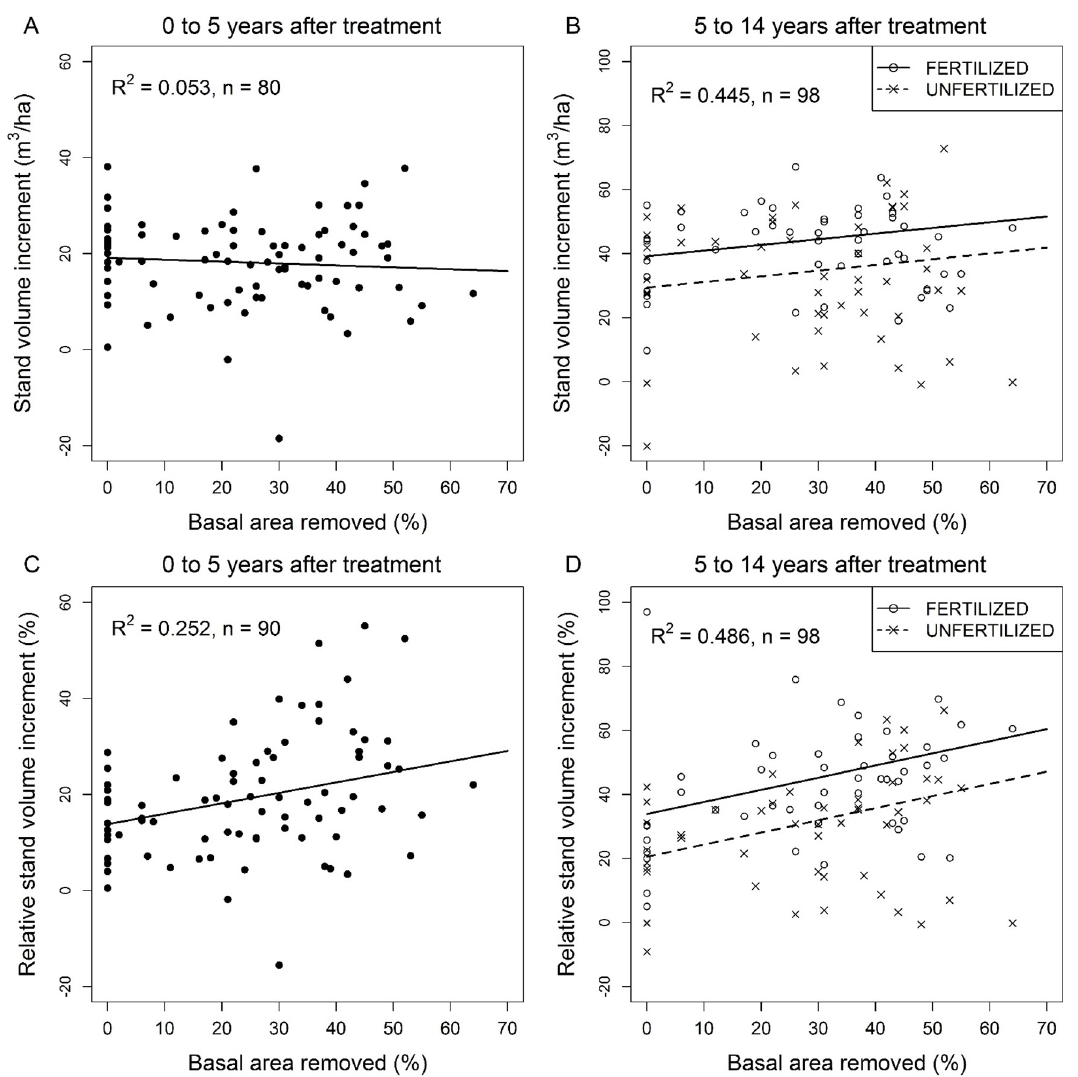
Figure 5. Jack pine stand response to commercial thinning and fertilization over the 5- to 14-year period following commercial thinning; ( A ) Stand volume increment over the first 5 years after commercial thinning in unfertilized plots as a function of basal area removed; ( B ) Stand volume increment between 5 and 14 years after thinning as a function of basal area removed and fertilization; ( C ) Relative stand volume increment over the first 5 years after commercial thinning in unfertilized plots as a function of basal area removed; ( D ) Relative stand volume increment between 5 and 14 years after thinning as a function of basal area removed and fertilization. Untransformed observed (dots) and predicted (lines)